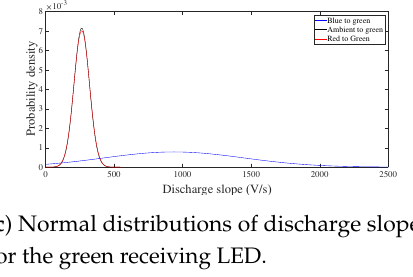
Figure 12. Statistical analysis of the monochromatic receiving LEDs when illuminated by red and blue sources and ambient